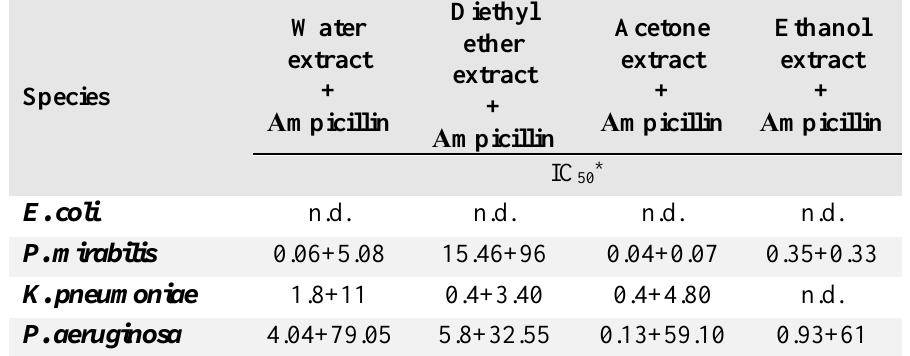
values of the most effective combination between A. eupatoria extracts and ampicillin. 50